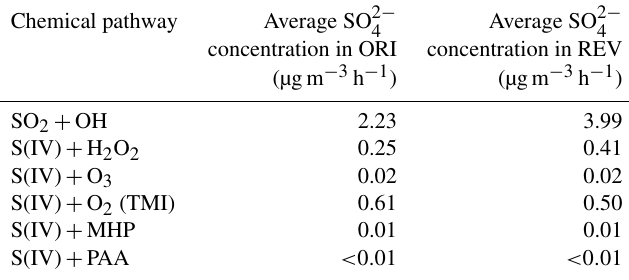
Table 3. Predicted SO 2 − concentration in Beijing from different chemical pathways in CMAQv5.3. 4